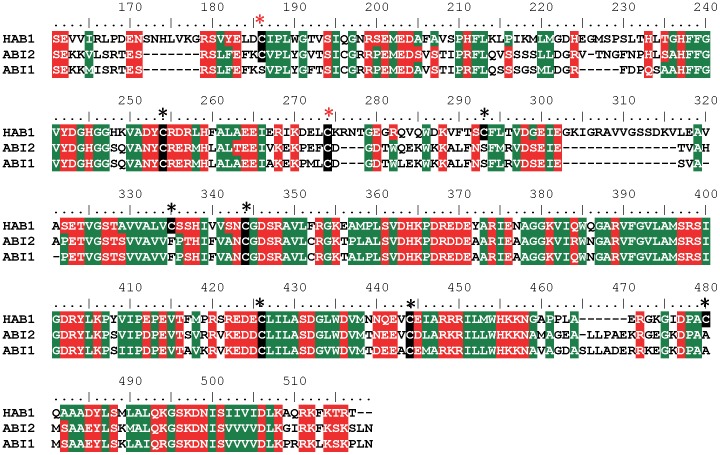
Sequence alignment of HAB1, ABI2 and ABI1.Cysteines in the phosphatase domain of HAB1 are indicated by black boxes and asterisks. C186 and C274 are highlighted by red asterisks. The numbers on top of the alignment indicate amino acid positions within HAB1.